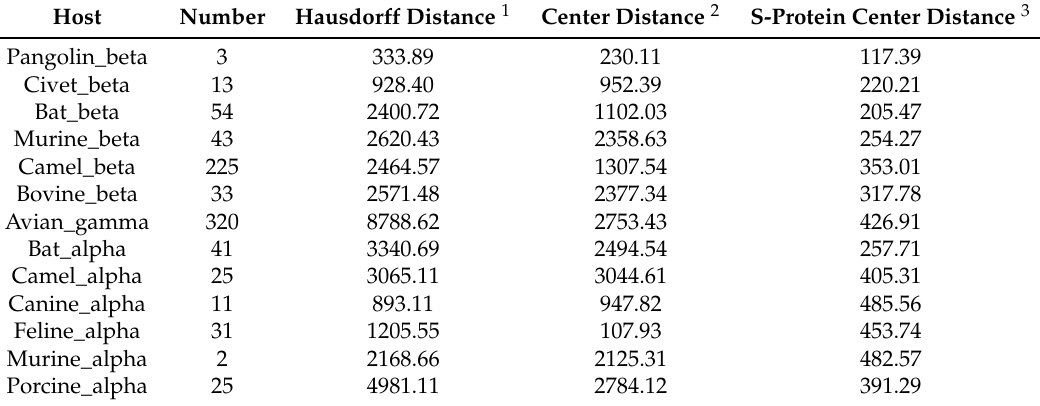
Table 2. Distance from SARS-CoV-2 group to the coronavirus group of each